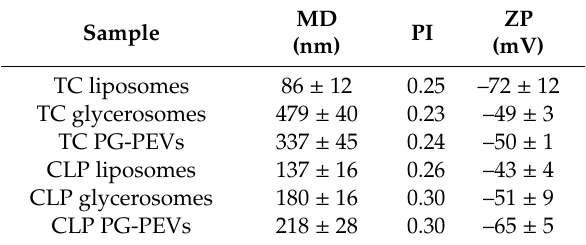
Table 3. The main physico-chemical properties of TC and CLP loaded liposomes, glycerosomes, and PG-PEVs are reported: Mean diameter (MD), polydispersity index (PI), and zeta potential (ZP) estimated by dynamic and electrophoretic light scattering. Mean values ± standard deviations were obtained from 8 replicates.